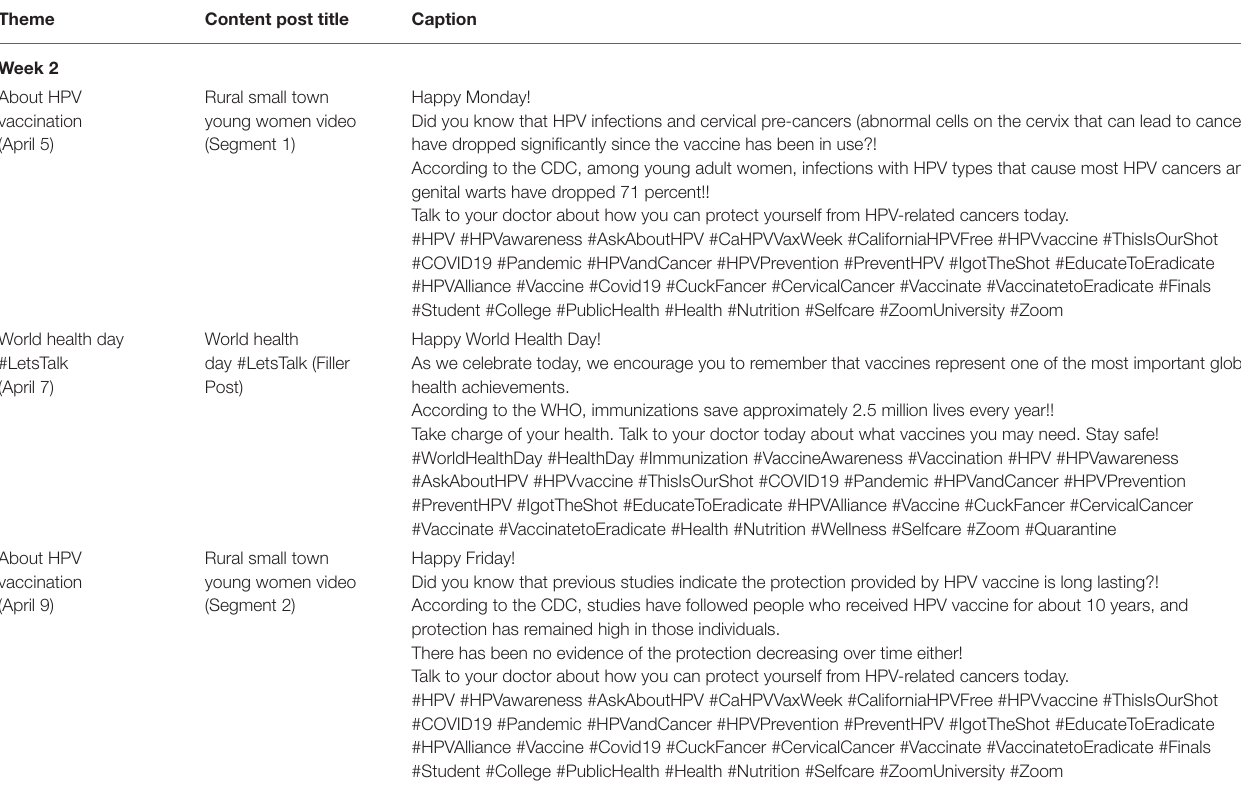
TABLE 2 | Example content calendar of weekly social media themes and postings April